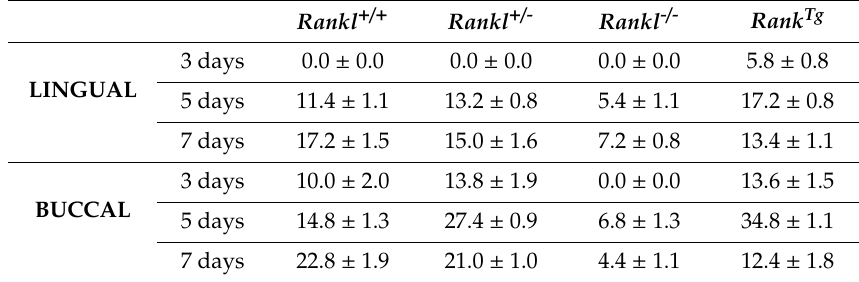
Table 1. Quantification of epithelial cells in Hertwig’s epithelial root sheath (HERS) based on keratin-14 staining by genotype and age in both the lingual and buccal regions. Sections from five mice were analyzed for each genotype and at each